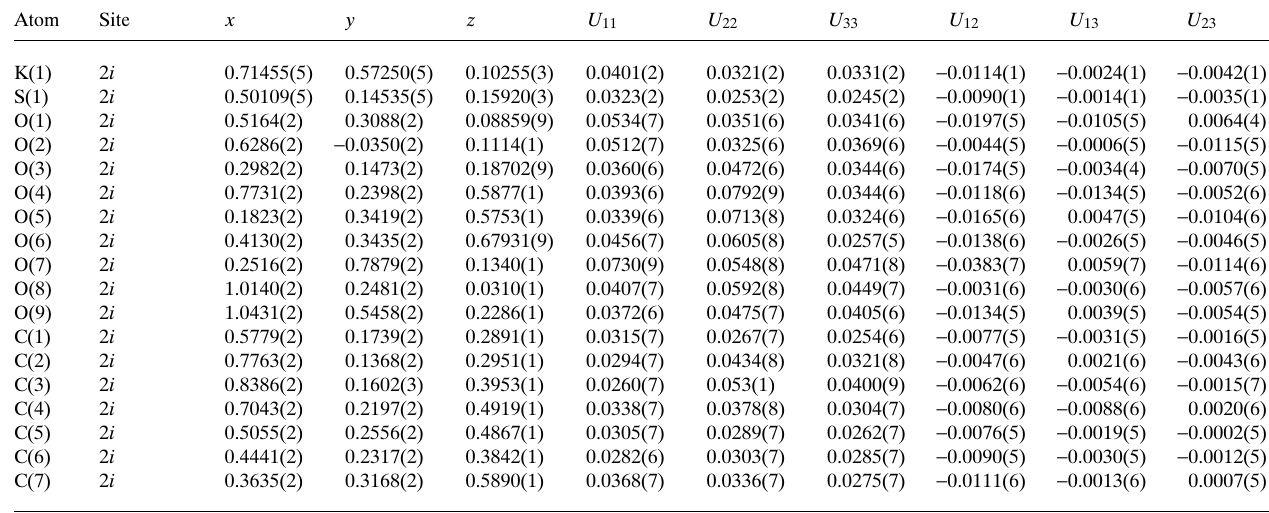
Table 3. Atomic coordinates and displacement parameters (in Å 2 ) .